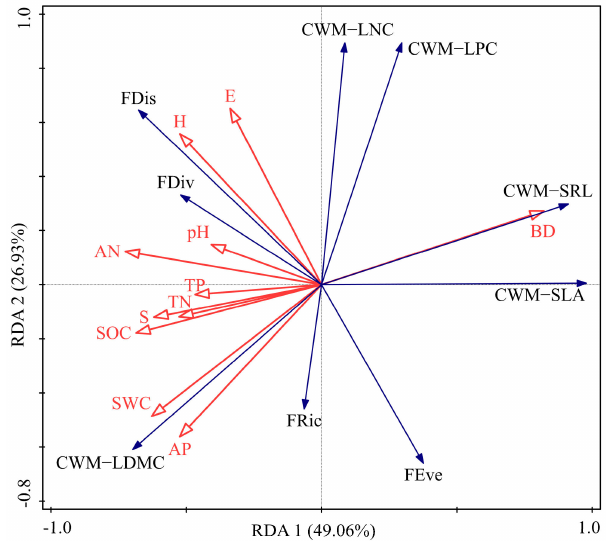
Figure 3. Redundancy analysis (RDA) of functional diversity indices and basic soil characteristics in four restoration communities. Functional diversity indices are represented as blue lines; soil characteristics and species diversity are represented as red